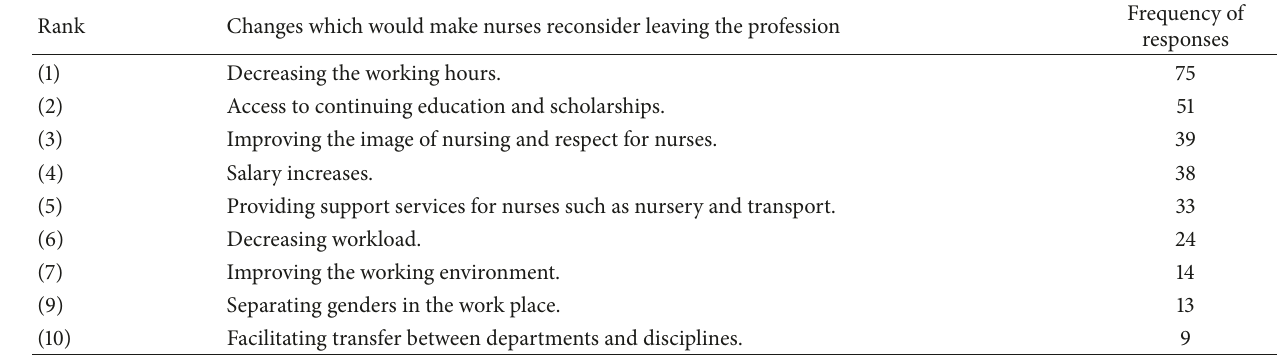
Table 6: Changes which would impact on decision to leave the